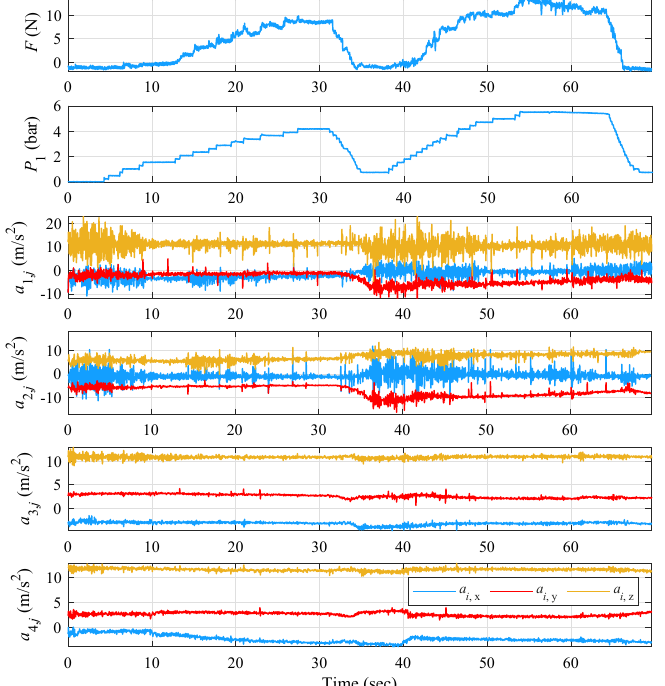
Figure 9. Experimental evaluation of iteration (A) and the effect of applying resisting force on the ET-diagnosed volunteer’s index-finger under open-loop changes in applied pressure and while the hand is at extended pose; Exp. 1.